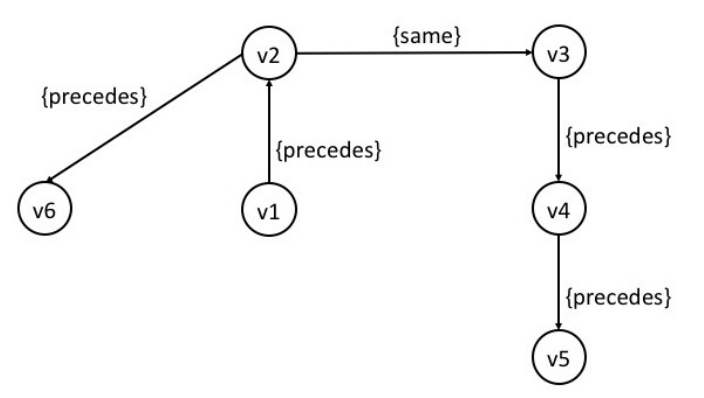
Figure 19. Qualitative Constraints Networks (QCN) when temporal entities are time